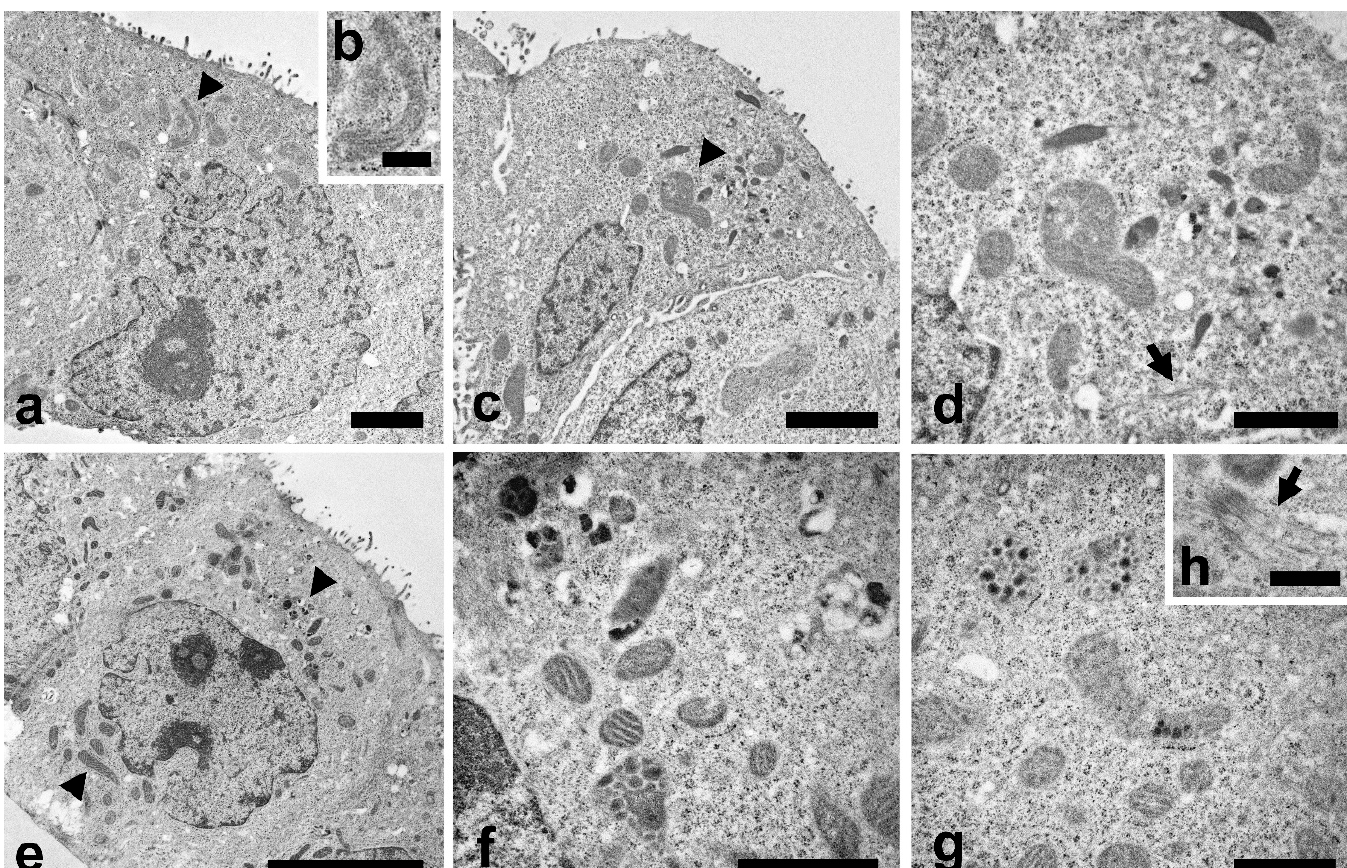
Figure 4. TEM investigations were carried out to evaluate morphological changes induced by LEO and NanoLEO treatments. ( a ) TEM micrograph of untreated Caco-2 cells at low magnification with mitochondria well visible (arrowhead); ( b ) Normal mitochondrion; ( c ) TEM micrograph of Caco-2 cells treated for 4 h with LEO; altered mitochondria (arrowheads); ( d ) A particular of the LEO cell where altered mitochondria were visible; apoptotic microtubule network were observed (arrow); ( e ) TEM micrograph of NanoLEO treated Caco-2 cells (arrowheads: mitochondria); ( f , g ): Two particulars of the NanoLEO treated Caco-2 cells; with altered mitochondria; ( h ) apoptotic microtubule network were observed (arrow); ). Bars = ( a ) 2 µm; ( b,h ) 500 nm; ( c ) 2 µm; ( d,f,g ) 1 µm; ( e ) 5 µm.